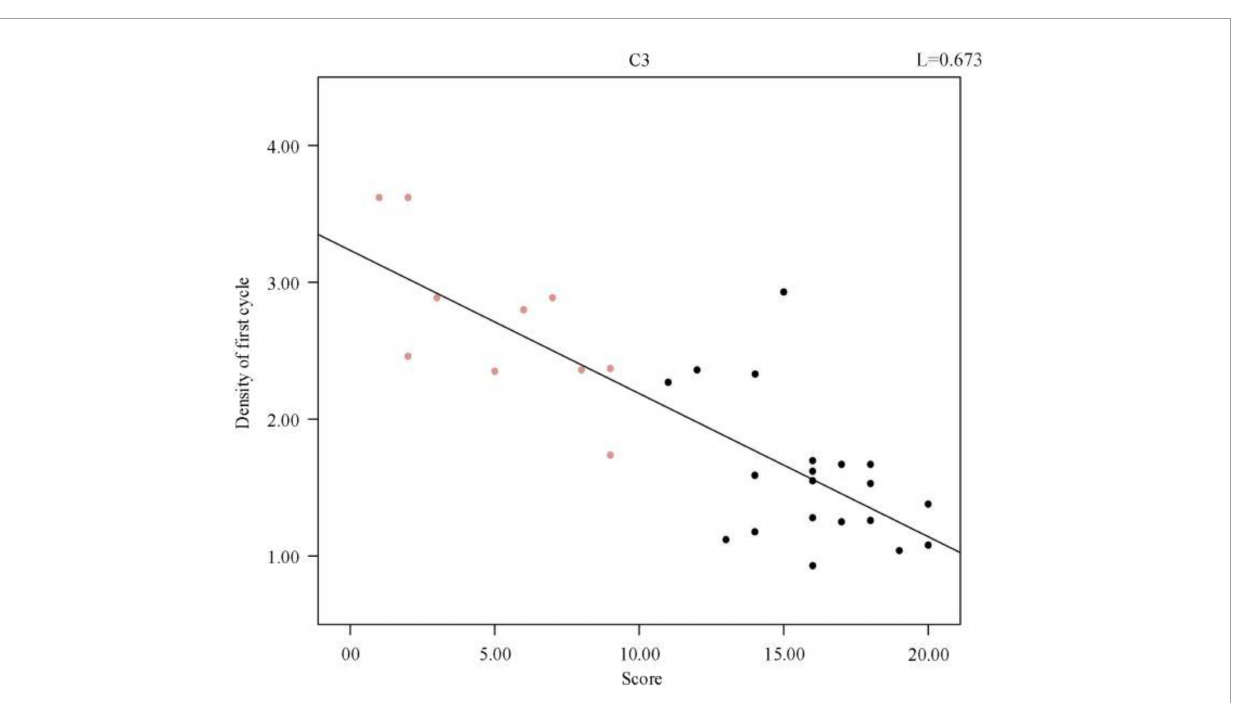
FIGURE5 Regression line between individual sleep first cycle spindle density and sleep quality score.